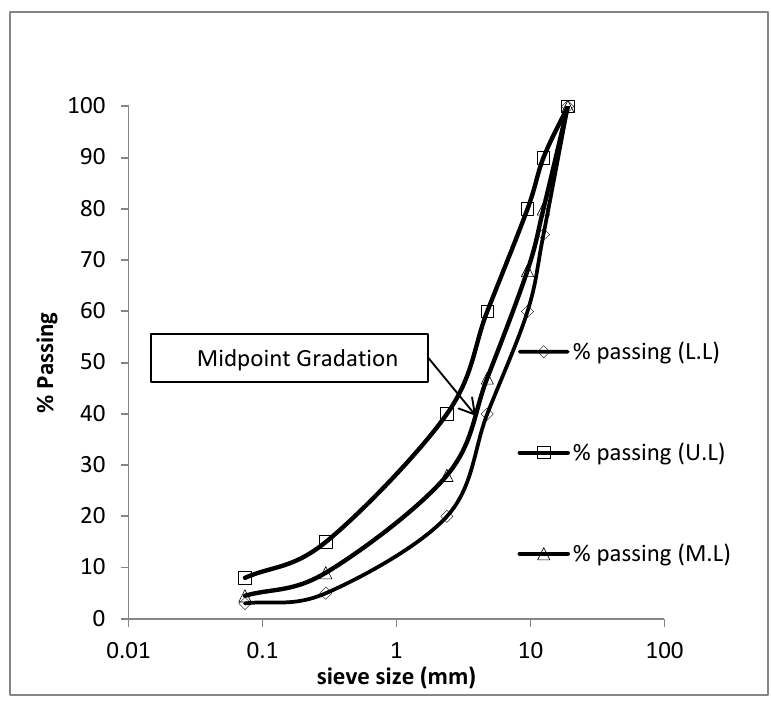
Figure 1. The aggregate gradation curve.